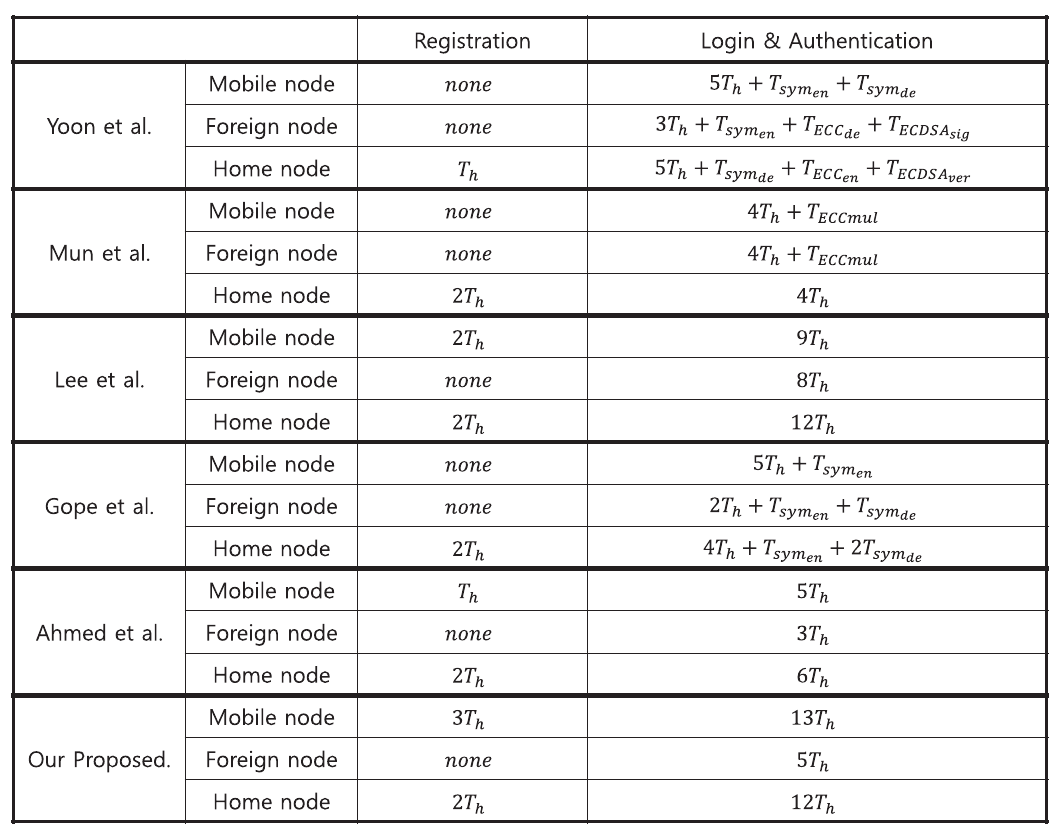
Fig 19. Computation time for each GLOMONET environment scheme.